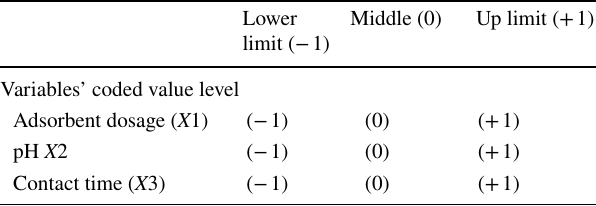
Table 1 Independence factors and their coded